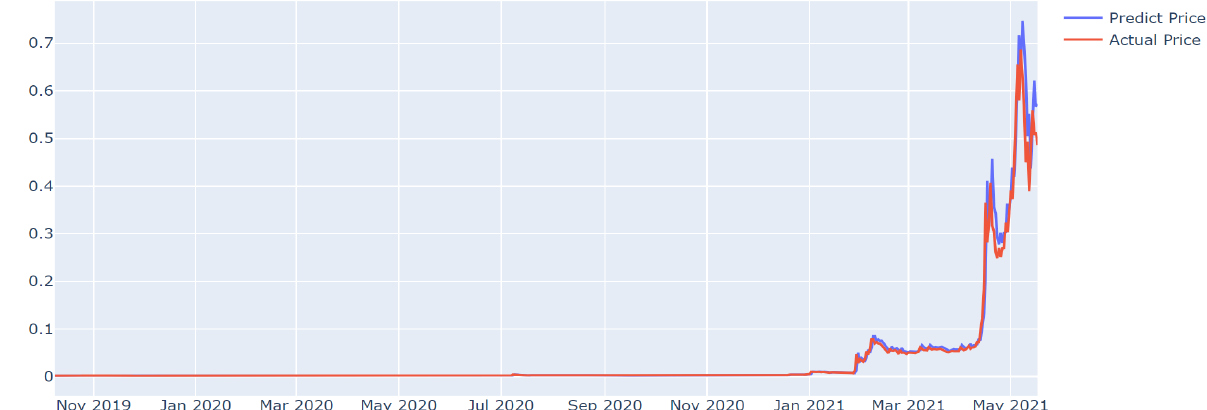
Fig. 10. Price prediction graph when two features (High & Low) are removed from feature